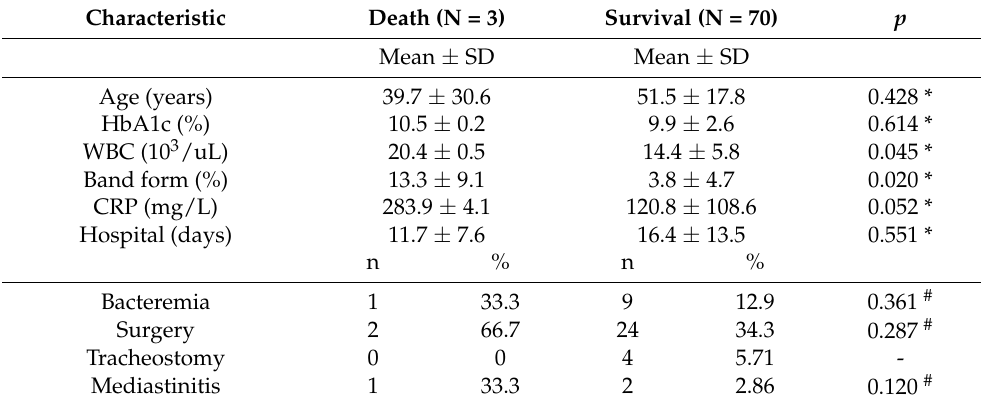
Table 4. Analysis of characteristics between the death and survival subgroups of